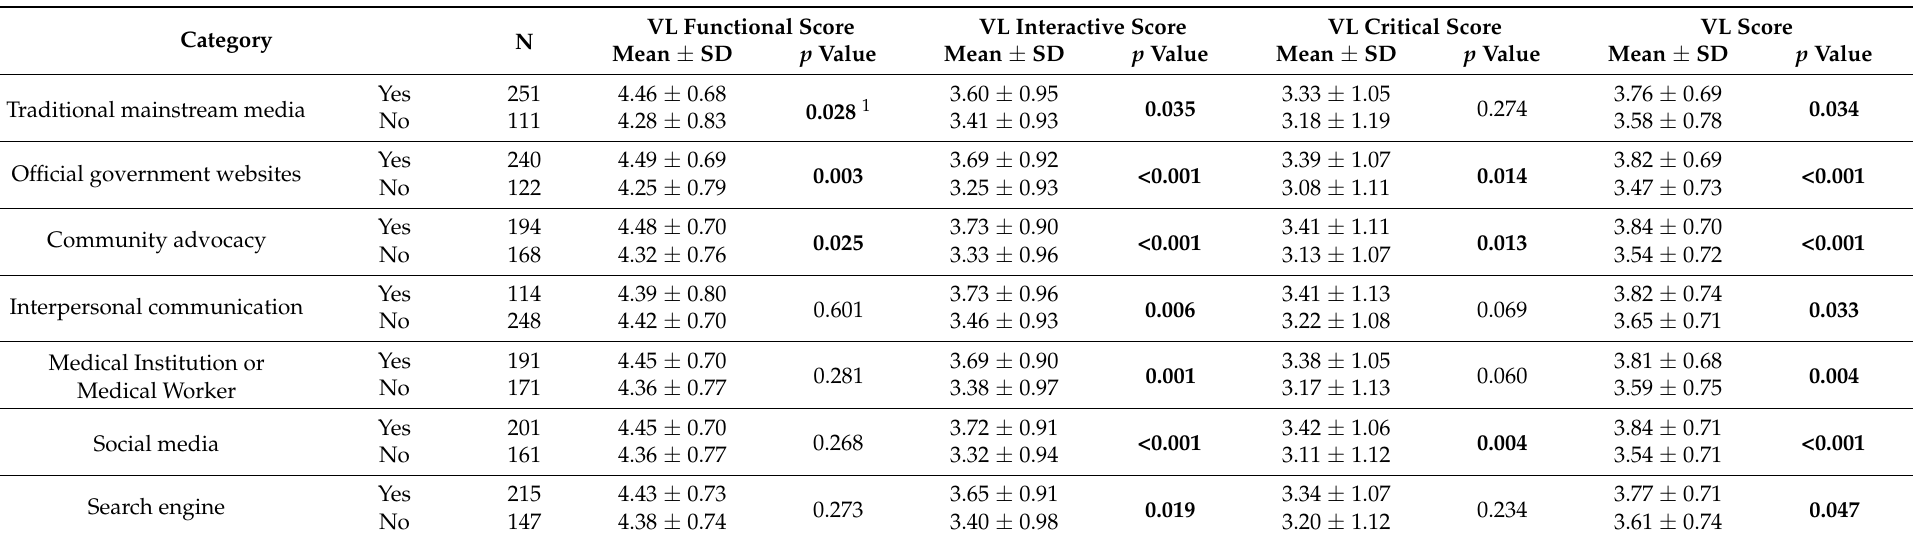
Table 5. Relationship between information sources and COVID-19 vaccine